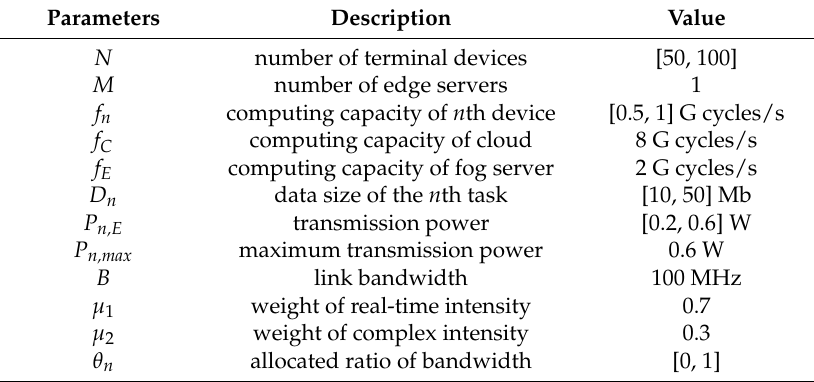
Table 1. Parameter values of the simulation.